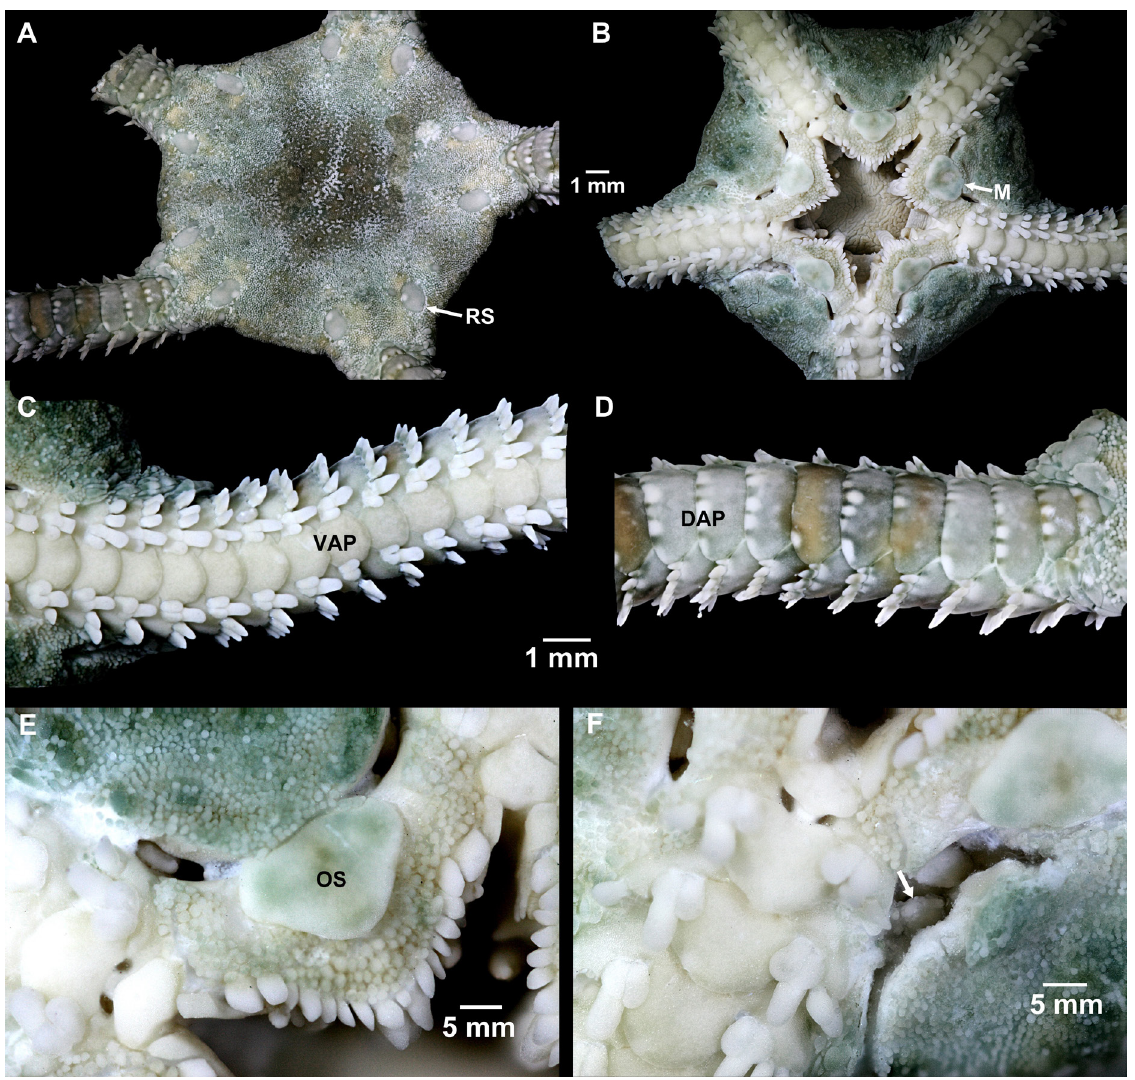
Fig. 11. Ophioderma zibrowii sp. nov., holotype (SMNH-Type-9188), digital images. A . Dorsal aspect, note the naked radial shields. B . Ventral aspect. C . Ventral arm. D . Dorsal arm, note the entire plates. E . Jaw. F . Brooded juveniles in interradius (arrow). Abbreviations: DAP = dorsal arm plate; M = madreporite; OS = oral shield; RS = radial shield; VAP = ventral arm